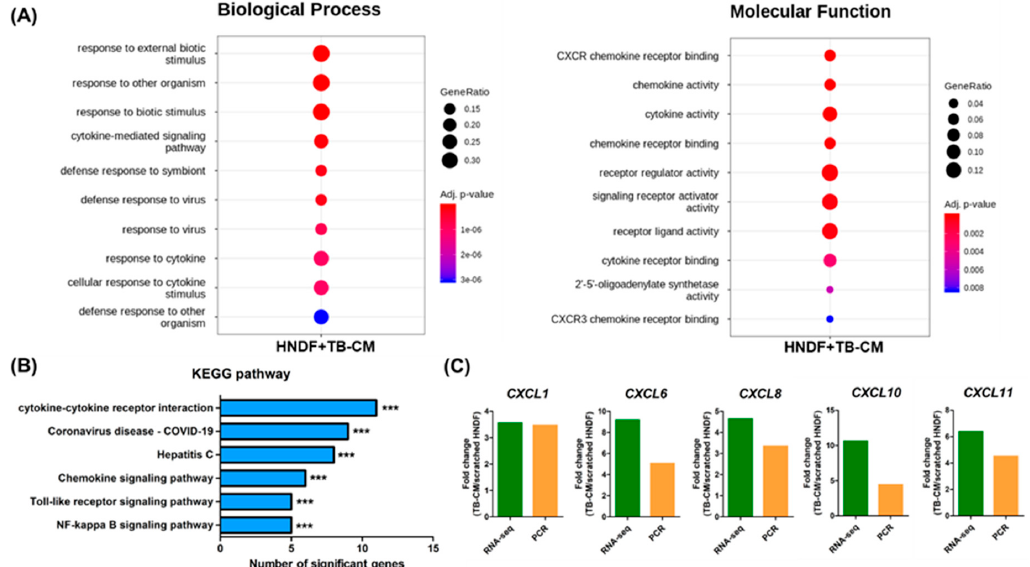
Figure 6. Changes in biological processes in HNDFs upon treatment with TB-CM. ( A ) The top 10 gene ontology terms of associated biological processes and molecular function from DEGs in TB-CM-treated HNDF cells are represented using a dot plot with adjusted p -value ( p < 0.05). GeneRatio is the intersection size/query size, while the dot size represents the intersection size. ( B ) KEGG pathway analysis showed the significantly correlated biological pathways in the results of RNA-seq upon treatment of HNDFs with TB-CM during scratch wound migration. ( C ) The representative upregulated CXCL-related genes, namely CXCL1, CXCL6, CXCL8, CXCL10, and CXCL11, in TB-CM-treated HNDFs were confirmed using quantitative real-time RT-PCR and compared with the results of RNA-seq.